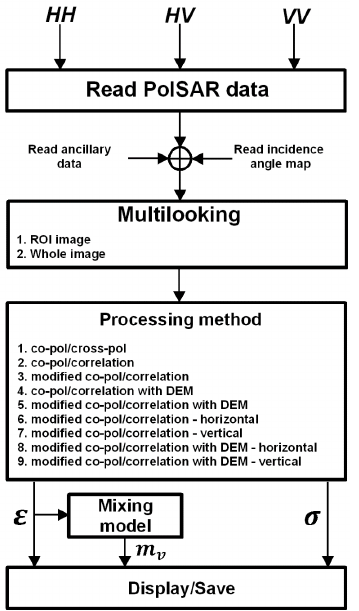
Figure 5. PTSM-Object-Oriented Program (OOP) program workflow, from the reading of polarimetric Synthetic Aperture Radar (SAR) data, to the visualization of permittivity ε , surface roughness σ and percentage of volumetric water content m v . ROI: Region of Interest.